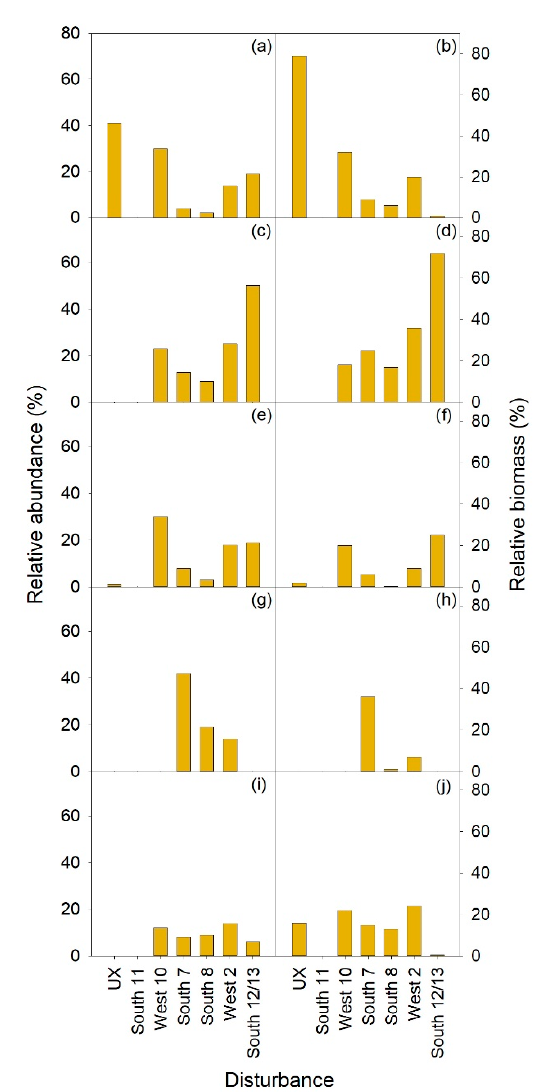
Figure 9. The Xerophyllum tenax (XETE) habitat type phase 30 years after disturbance and the relative abundance values (%) for seedlings of ( a ) Abies lasiocarpa , ( c ) Larix occidentalis , ( e ) Picea engelmannii , ( g ) Pinus contorta , and ( i ) Pseudotsuga menziesii var. glauca , along with their respective relative biomass values (%) ( b , d , f , h , j ). Note: x-axis values progress from undisturbed forest (left) to the highest severity disturbance (right); see Table 1 for disturbance category descriptions.